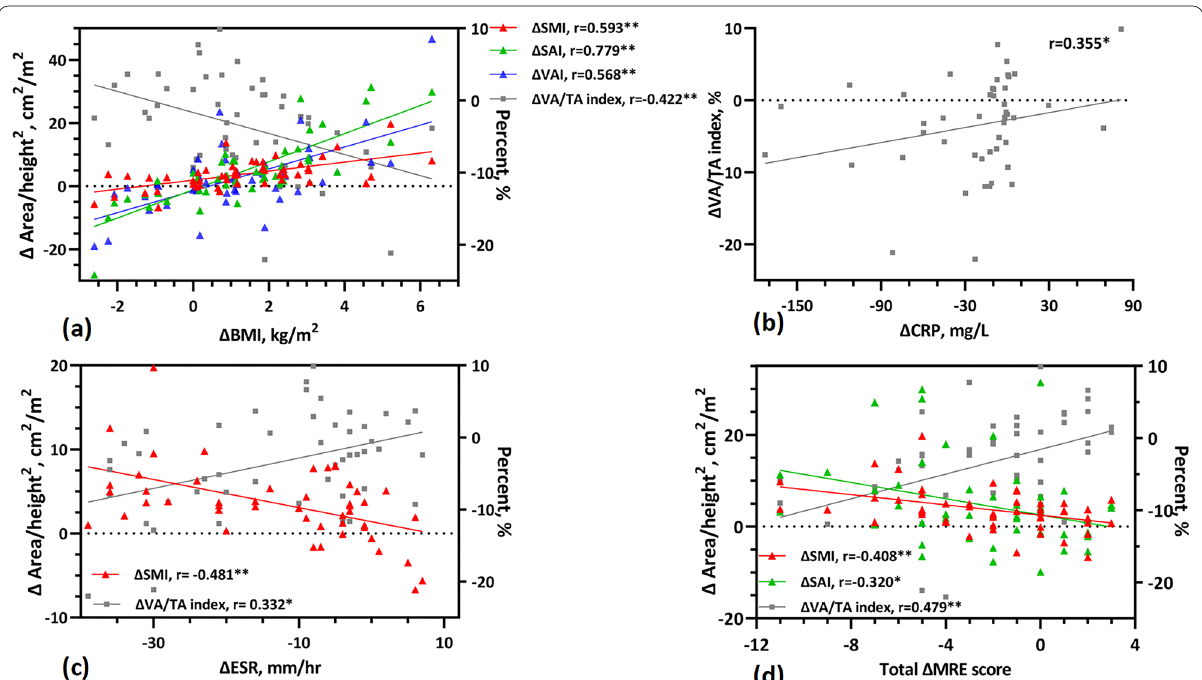
Fig. 6 Scatter plots showing the correlation between changes in clinical indicators, MRE score, and body composition parameters during follow-up. a Correlation between changes of body composition parameters (ΔSMI, ΔSAI, ΔVAI, and ΔVA/TA) and BMI; b Correlation between ΔVA/TA and ΔCRP; c Correlation between changes of body composition parameters (ΔSMI and ΔVA/TA) and ESR; d Correlation between changes of body composition parameters (ΔSMI, ΔSAI, and ΔVA/TA) and total MRE score. **: p < 0.01, *: p < 0.05; BMI, body mass index; CRP, C-reactive protein; ESR, Erythrocyte sedimentation rate; SMI, skeletal muscle index; SAI, subcutaneous adipose index; VAI, visceral adipose index, VA/TA index: VAT to total adipose tissue